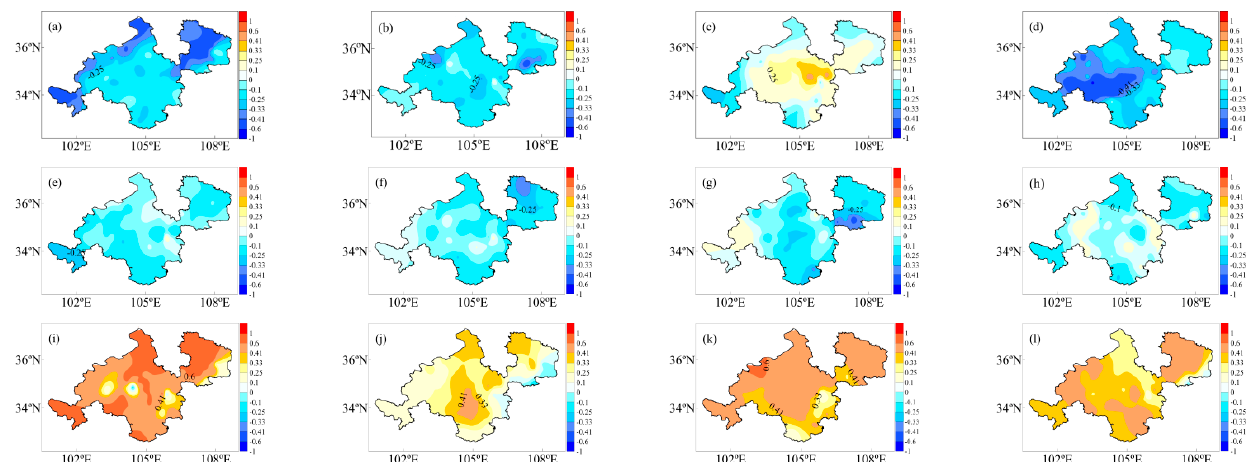
Figure 10. Correlation between drought intensity and precipitation heterogeneity in each season (columns 1–4 are spring, summer, autumn, and winter, respectively; ( a – d ) is PCD, ( e – h ) is PCP, ( i – l ) is the number of days with weak precipitation; r > 0.25 represent those significant at the 0.05 level based on the Student’s t